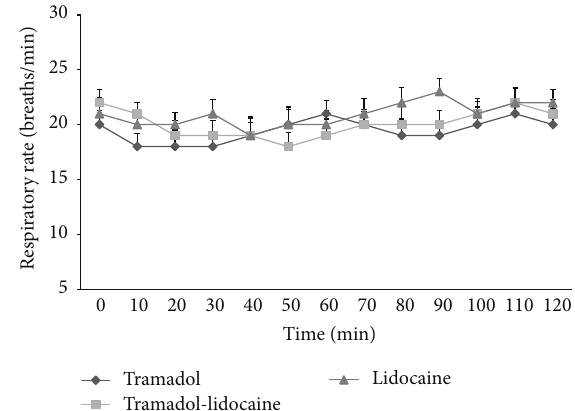
Figure 4: Mean respiratory rate (breaths/minute) after epidural analgesia of tramadol, tramadol-lidocaine combination, and lido- caine in buffalo calves (mean ± SD in 10 calves). Error bars indicate the standard deviation of the